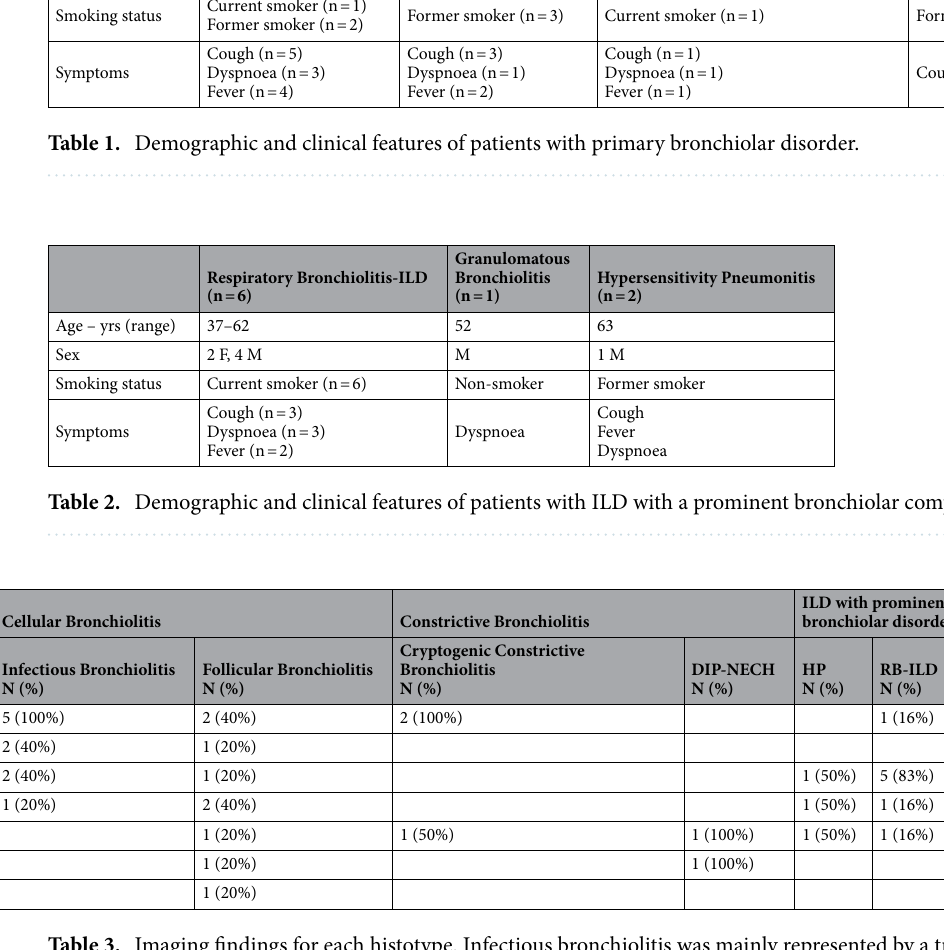
Table 3. Imaging findings for each histotype. Infectious bronchiolitis was mainly represented by a tree-in- bud pattern. Follicular bronchiolitis was characterized by ill-defined centrilobular nodules and ground-glass attenuation. Constrictive bronchiolitis was characterized by tree-in bud patterns and mosaic attenuation. DIPNECH was characterized by the coexistence of nodules and mosaic attenuation. In HP, ill-defined centrilobular nodules were associated with air trapping and ground-glass attenuation. Granulomatous bronchiolitis was characterized by ill-defined